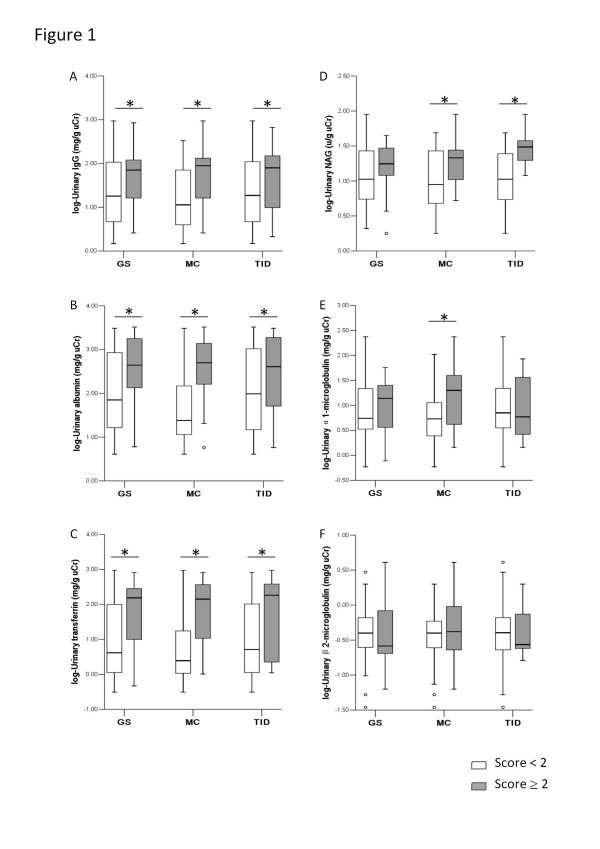
Comparison of urinary protein markers between children with mild and severe renal histological lesions. Comparison of urinary proteins between children with severe mesangial cellularity (MC) defined as > 5 mesangial cells/ mesangial area (score ≥ 2, n = 34) and those with mild MC (score < 2, n = 64); between children with severe glomerulosclerosis (GS) defined as ≥ 10 % glomeruli showing segmental adhesions or sclerosis (score ≥ 2, n = 17) and those with mild GS (score < 2, n = 81); and between children with severe tubule-interstitial damage (TID) defined as focal or diffuse tubular and interstitial lesions (score ≥ 2, n = 20) and those with mild TID (score < 2, n = 78). Urinary excretion of IgG (A), albumin (B), transferrin (C), NAG (D), α1-microglobulin (E) and β2-microglobulin (F) was log transformed. Values are medians, boxes represent interquartile range, whiskers indicate smallest and largest non-outlier observation, and circles indicate outliers. Probability values: two-sample Kolmogorov-Smirnov test, *p < 0.05.